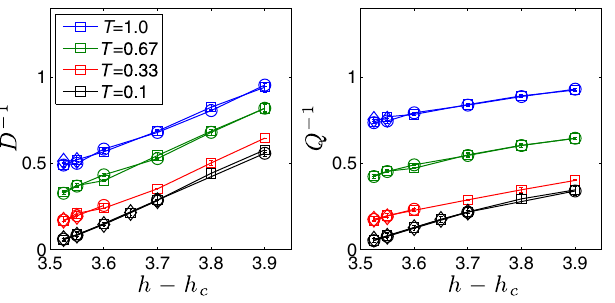
FIG. 10. Inverse nematic and quadrupolar susceptibilities versus h − h at various temperatures. Multiple system sizes c are shown with squares for L ¼ 16 , circles for L ¼ 20 , and diamonds for L ¼ 24 . The error bars reflect uncertainties due to finite system sizes, estimated from the differences between the measured susceptibilities of systems with different boundary conditions.